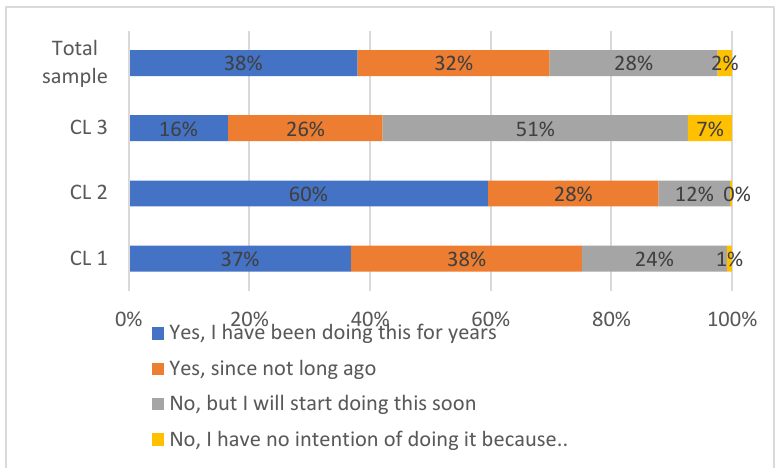
Figure 2. Do you teach your child to pay attention to the natural environment in the context of producing and consuming food?